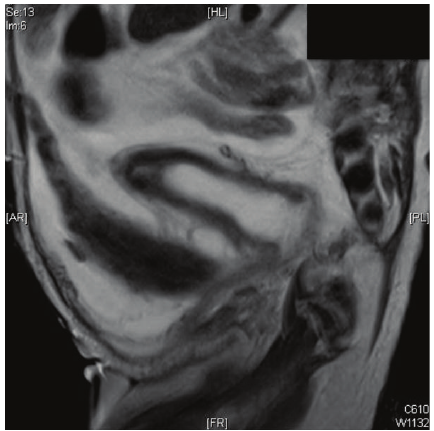
Figure 2: Pre-op MRI demonstrating an elongated bladder up to the level of urachus; a blind ending rectal pouch having no communication with the urogenital system; hydrometrocolpos; and absence of abdominal wall